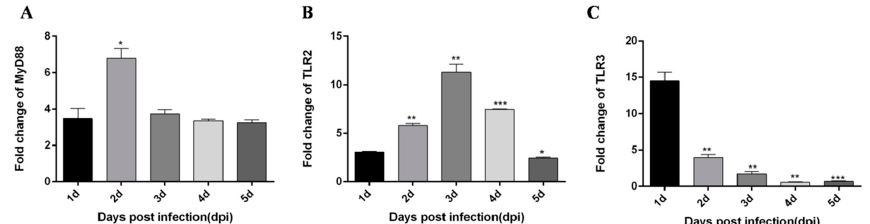
Figure 6. DTMUV-infected ducks e ff ectively up-regulate MyD88, TLR2, TLR3 expression in the spleen. Each young SPF duck was challenged by intramuscular inoculation with DTMUV. ( A – C ) Spleen tissues of mock- and DTMUV-infected ducklings were collected at the indicated time points for examination of